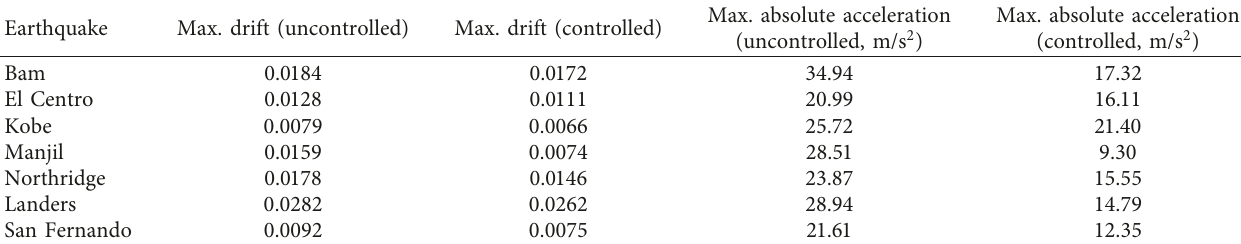
Figure 17: Uncontrolled/controlled responses under the San Fernando earthquake. (a) Roof displacement response. (b) TMD specifi- cations. (c) Objective values. Table 8: Comparison between controlled and uncontrolled drifts and absolute accelerations of the top story for different earthquake